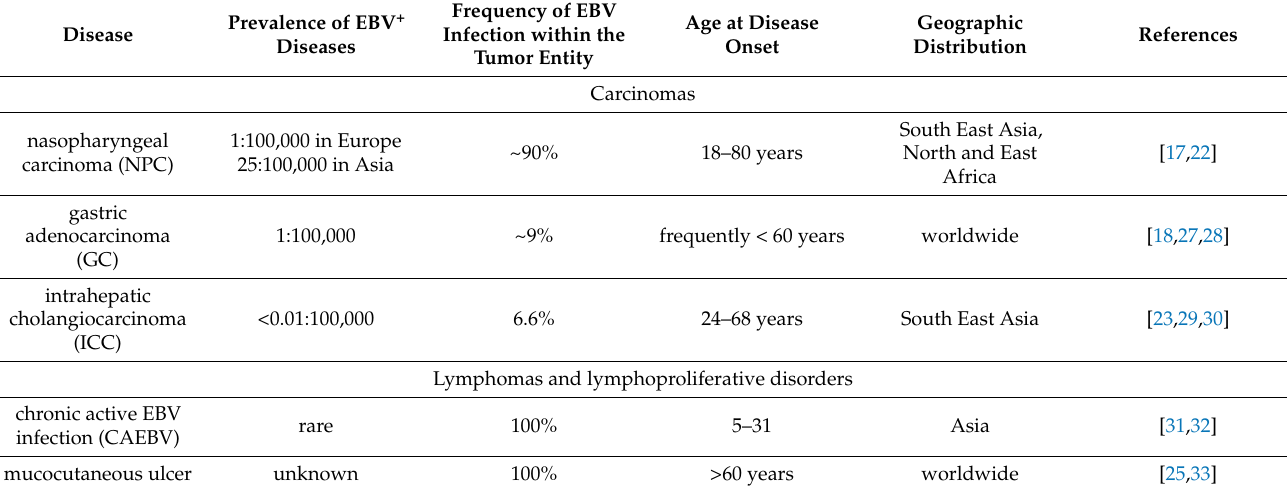
Table 1. Epidemiological features of EBV-associated